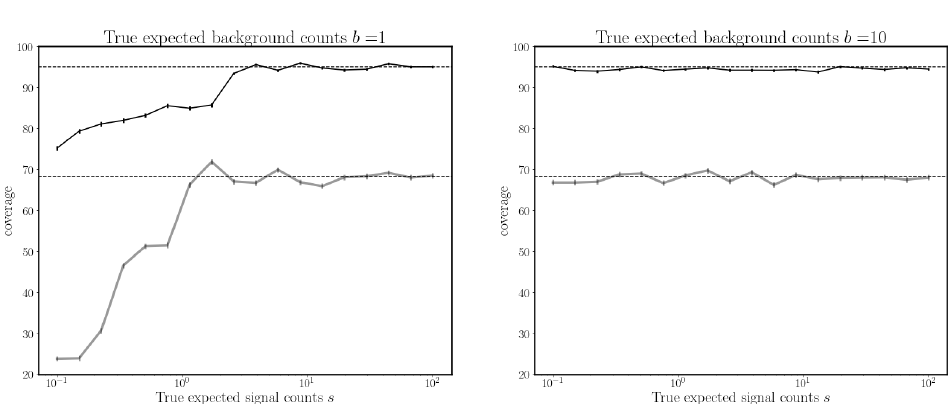
Figure 9. Evolution of the coverage of the CIs obtained from solving S = 1 (grey line) or S = 3.84 (black line) as a function of the signal s . S is the statistic defined in Equation (27). The dashed horizontal lines show the expected coverage from the assumption that S is a χ 2 -random variable with 1 degree of freedom. In each MC simulation the observed counts N on and N of f were simulated from a Poisson distribution with expected counts s + α b and b , respectively. Left panel : the expected background count is fixed to 1. Right panel : the expected background count is fixed to 10. In both plots α = 0.5 is